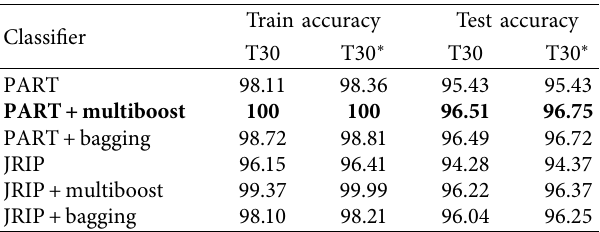
Table 9: Classifier performance in terms of train accuracy and test accuracy values for Exp.